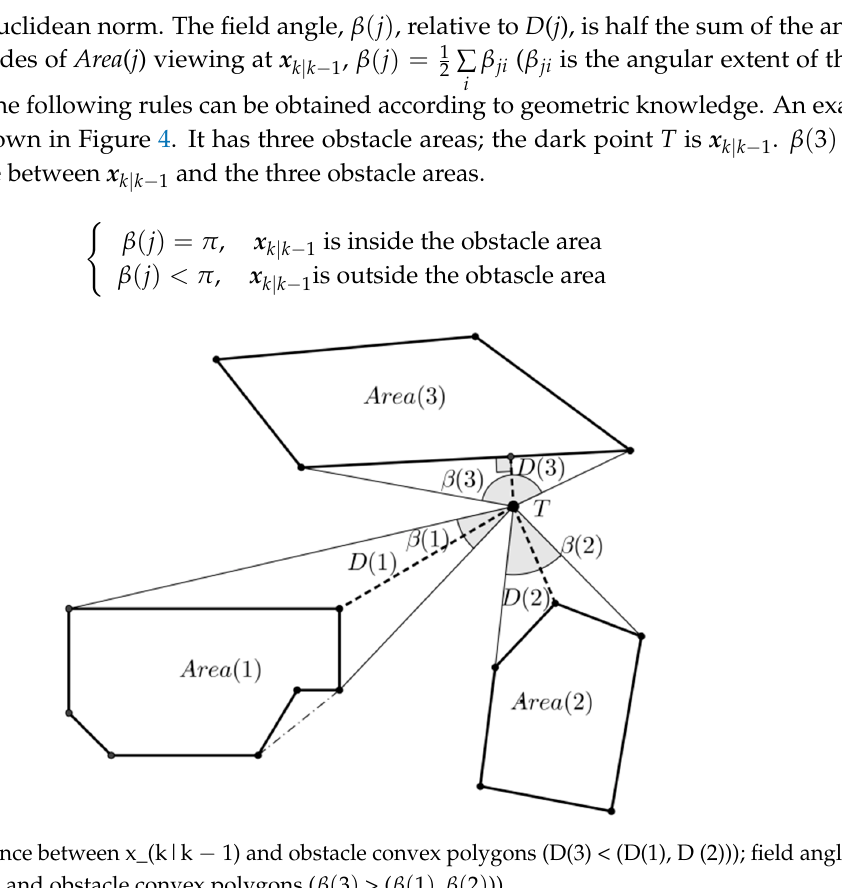
Figure 3. The schematic block diagram of the fuzzy-logic-based obstacle information-aided multiple-model (FOIA-MM) algorithm.